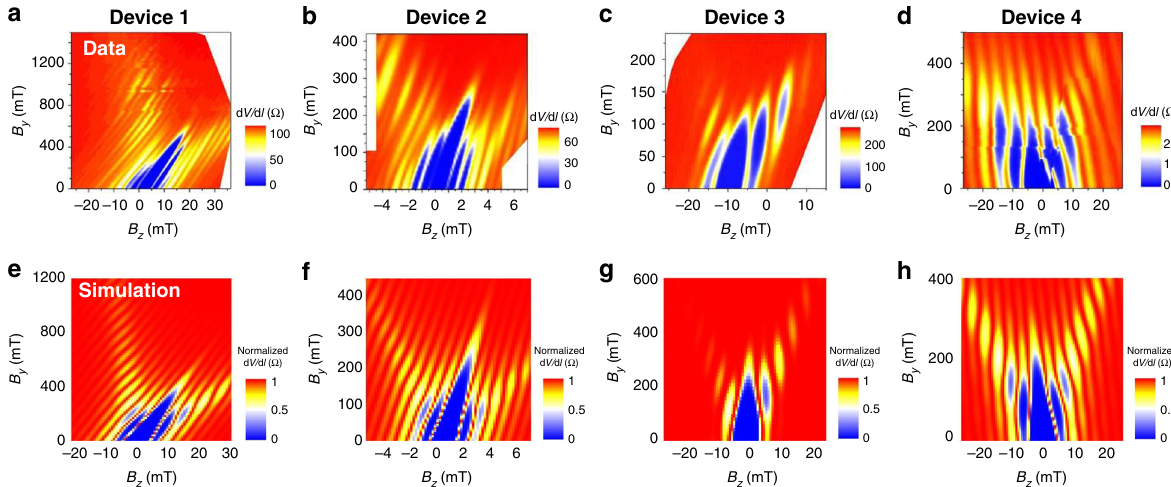
Fig. 6 Evolution of the Fraunhofer pattern across different devices. Comparison of the evolution of the Fraunhofer pattern when B y is applied to devices 1 –